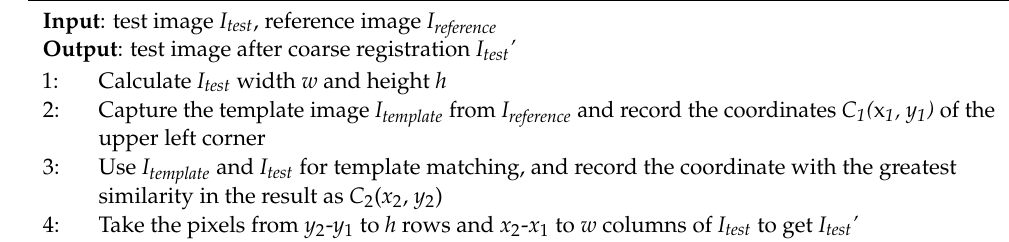
Algorithm 1: Coarse Registration Algorithm Based on Template Matching